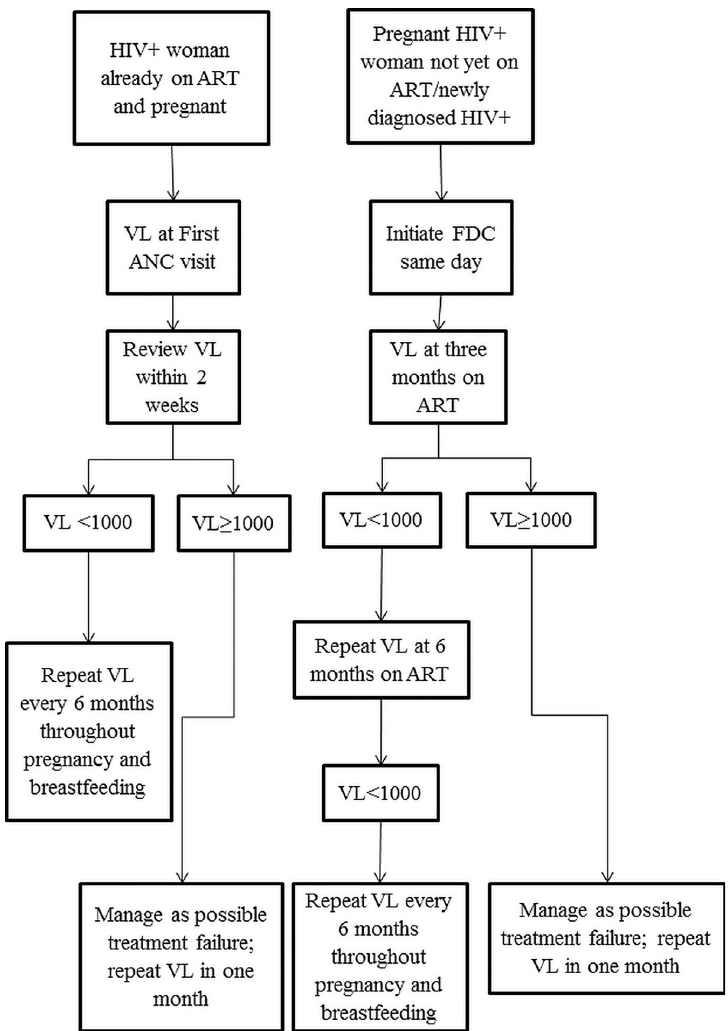
Fig 1. National algorithm for viral load testing among pregnant and breast feeding women living with HIV in Zimbabwe (2017). HIV–Human immunodeficiency virus; ART-Antiretroviral therapy; VL- Viral Load; FDC-Fixed dose combination; ANC-Antenatal